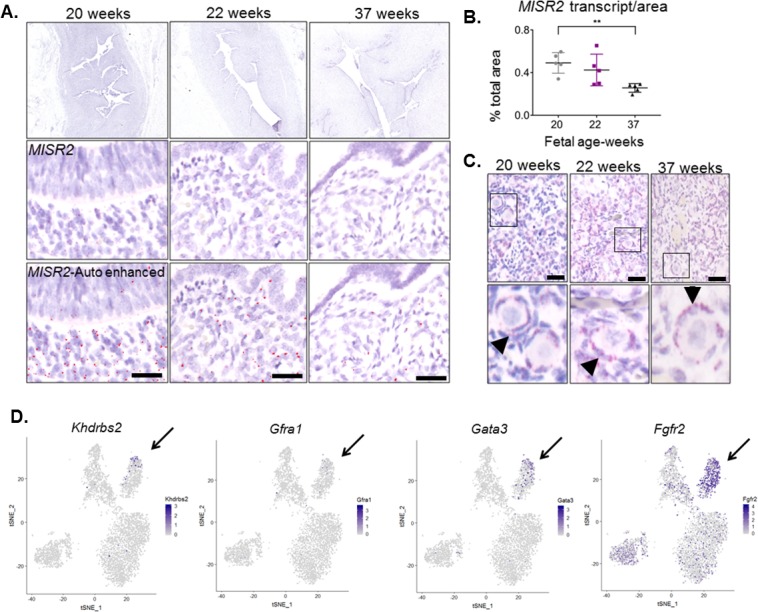
MISR2 is expressed in the subluminal mesenchymal cells of the developing human fetus, and progenitor genes may be implicated in Mullerian aplasia in humans.(A) The MISR2 expression pattern in human fetal uteri was analyzed by RNAish in fixed tissue sections. First row consists of stitched images of human fetal uteri at embryonic weeks 20, 22, and 37 (approximately 60 images (20x objective) per developmental time point were used for stitching). Middle-row panels show a higher magnification image for each subsequent time point. Red dots (MISR2 transcripts) were quantified using the Keyence BZ-X800 analysis software. Software-enhanced red dots in the bottom-row panels show the quantified region by the automated system. Scale bars = 25 µm (B) MISR2 transcripts were quantified per cell area from five random sections of 20, 22 weeks, and 37 weeks fetal tissue. (unpaired Student t-test, five section per one sample, per time point, **(p<0.01)). (C) Adjacent human fetal ovaries were used as internal positive controls for the MISR2 RNAish analysis. Black arrowheads indicate granulosa cells from primordial follicles positive for MISR2 transcripts. Scale bars = 25 µm. (D) Candidate genes of Mullerian aplasia in humans have enriched expression in the ‘inhibited progenitor’ cluster (black arrows) from the t-SNE plots of scRNAseq in rats.